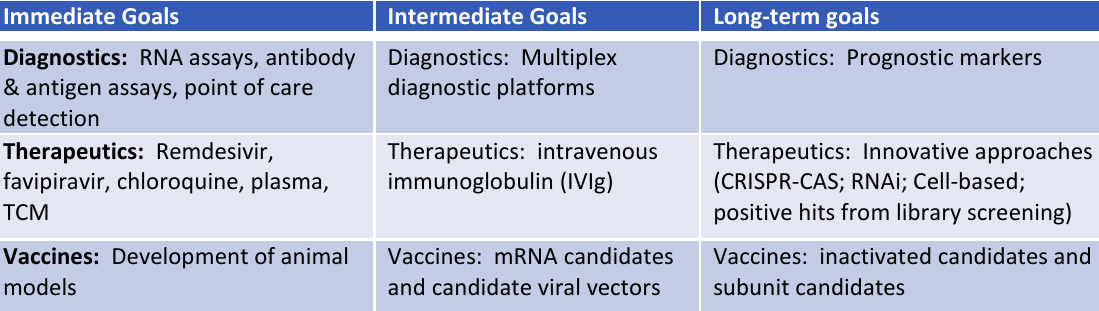
Table 1 Priority research areas with immediate, intermediate and longer-term goals Immediate